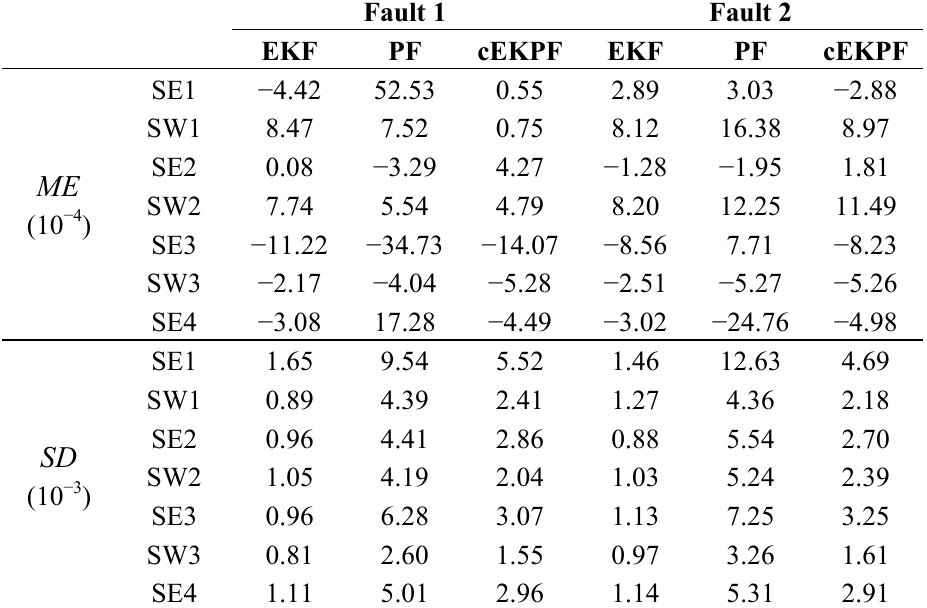
Table 4. Mean error and standard deviation of the estimation with Gaussian noise.